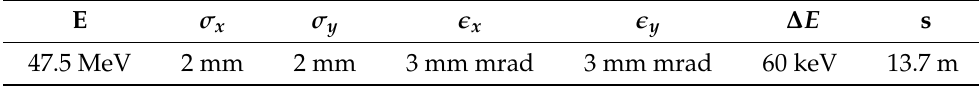
Table A6. Target vector for the biased AWA optimisation.